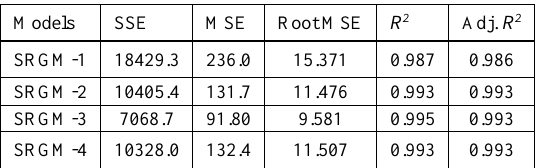
Table 4. Comparison results for data set 2